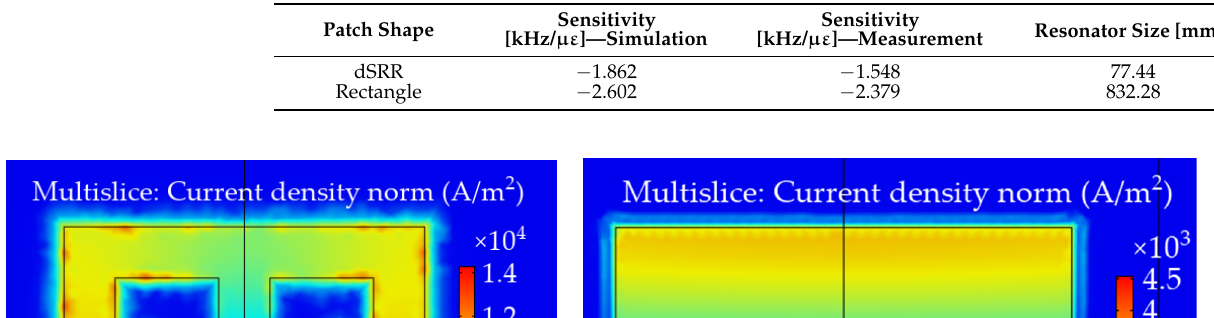
Table 1. Comparison of the studied sensors.